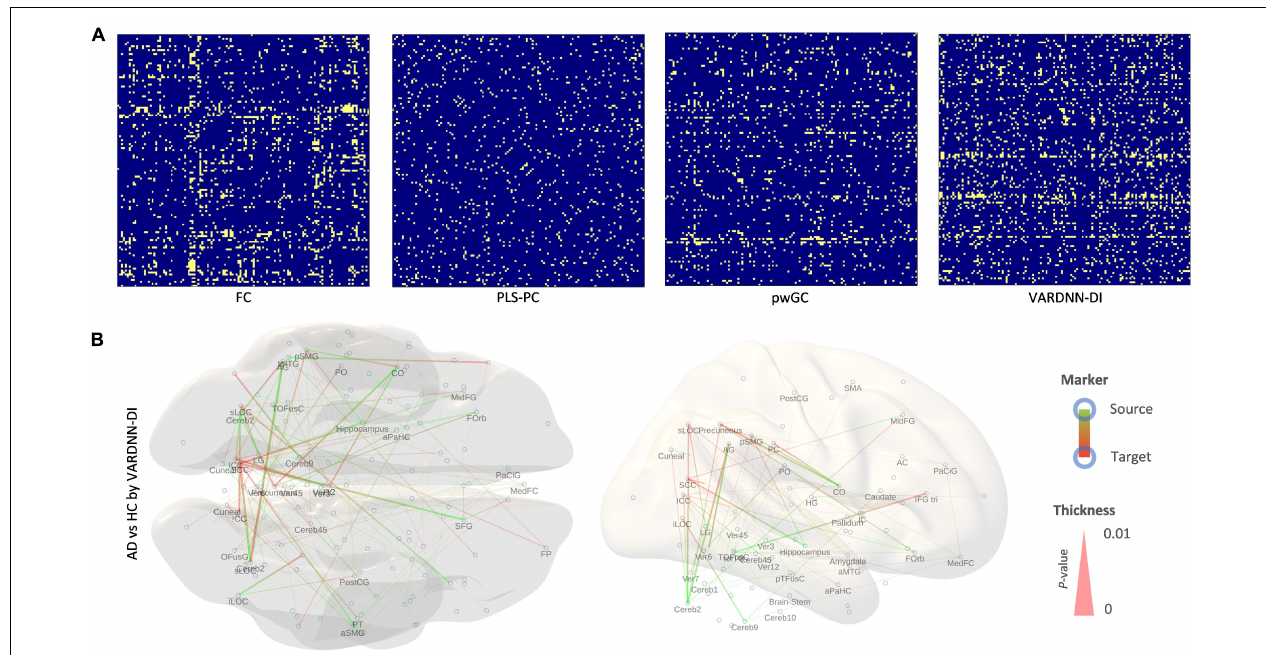
FIGURE 9 | (A) Significantly different ( p < 0.05, yellow color; non-significant, blue color) regional relationship matrices between AD and HC groups. From left to right, FC, PLS-PC, pwGC, and VARDNN-DI, respectively. (B) The whole brain image of the most different (0 ≤ p < 0.0024) regional relationships by VARDNN-DI. The image on the left is seen from the dorsal view and the right image shows the medial view of the left hemisphere. Posterior is left and anterior is right. Blue circles are region centroids. The source to target areas are color coded from green to red. A smaller p -value shows a thicker